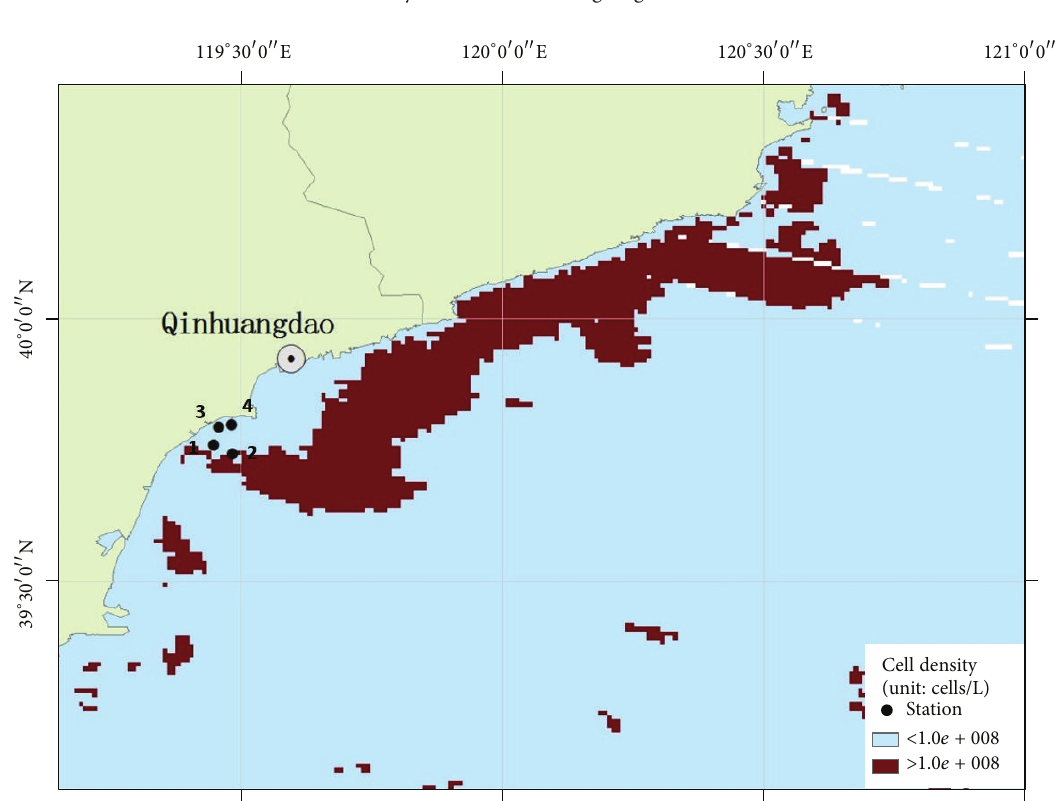
Figure 9: The distribution area of the Aureococcus anophagefferens red tide (single-band